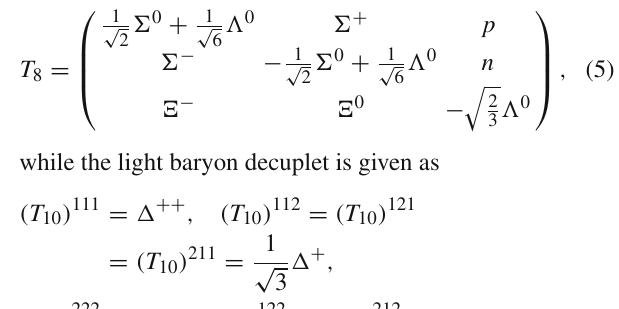
Quantum numbers of the doubly heavy baryons